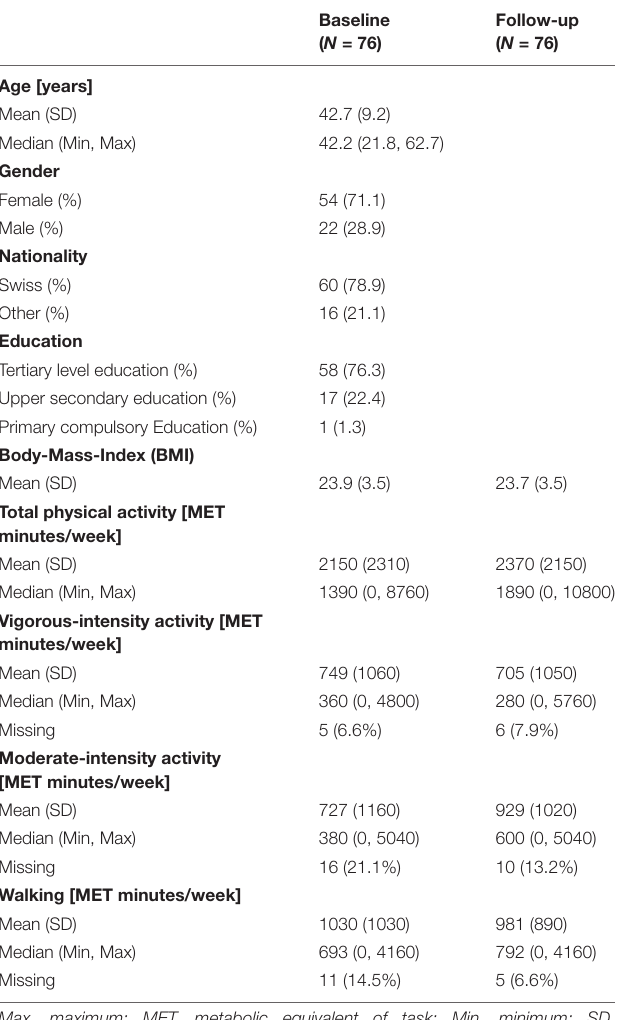
TABLE 1 | Participant characteristics at baseline (before the COVID-19 pandemic) and follow-up (during the